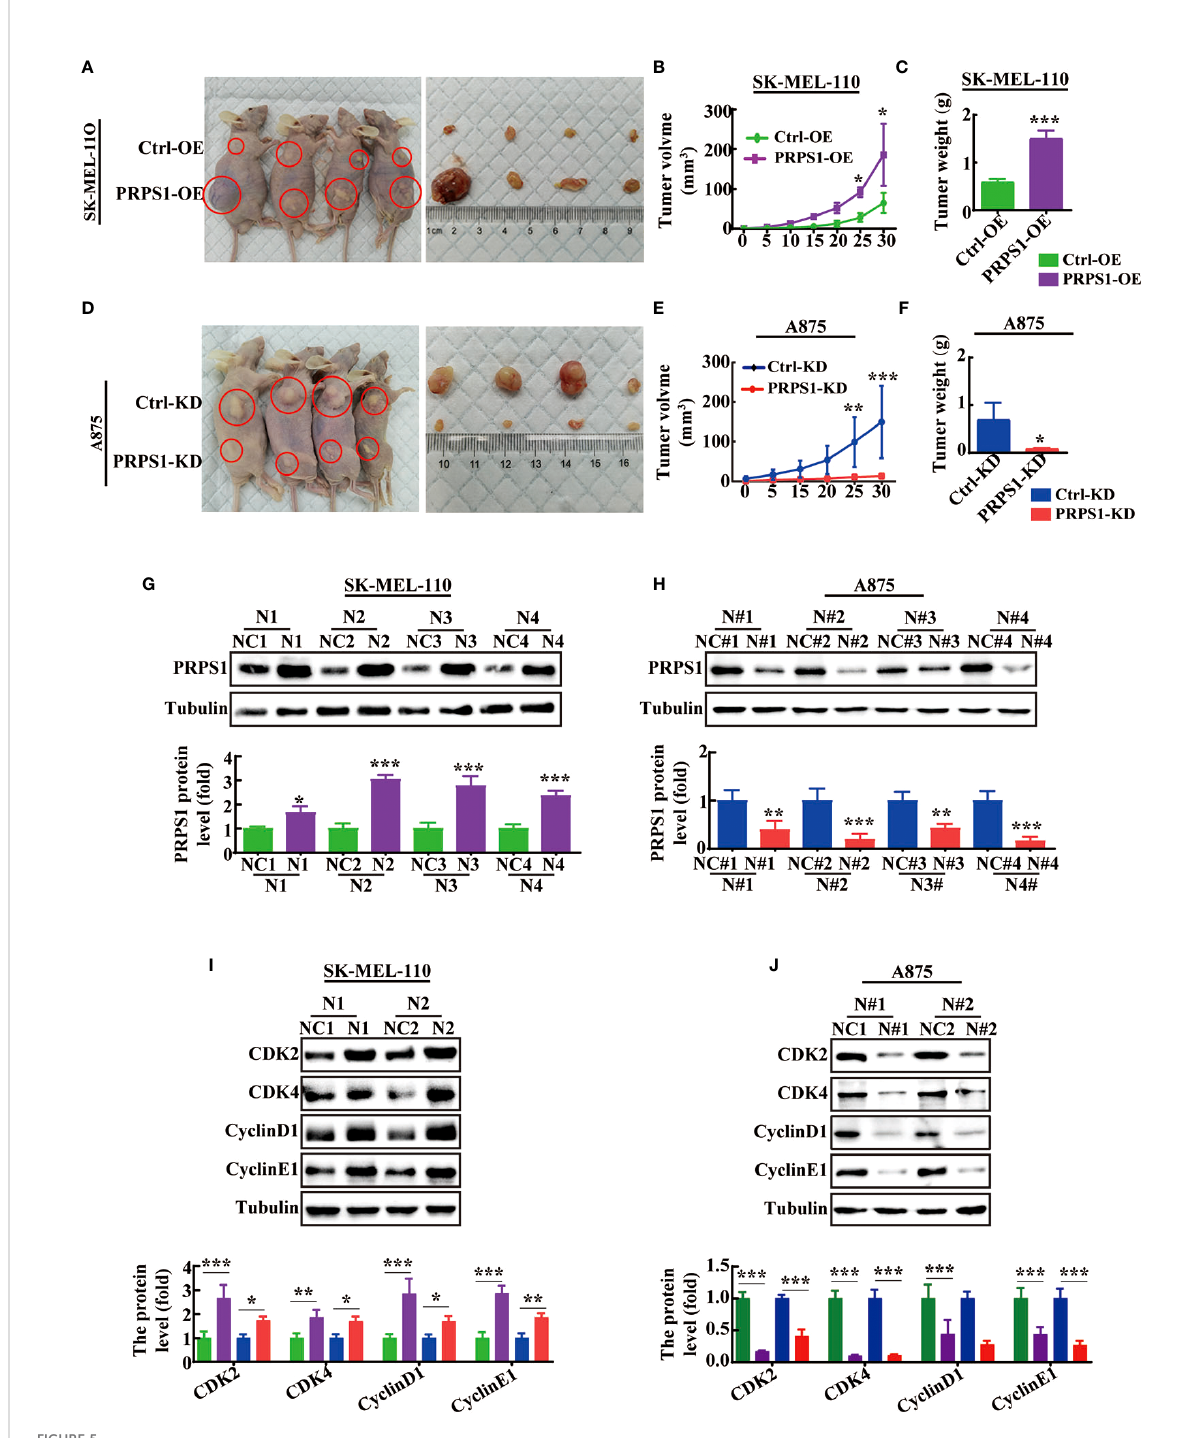
FIGURE 5 PRPS1 promotes melanoma cells proliferation in vivo. (A – C) BALB/c nude mice were injected with SK-MEL-110 cell that were stably transfected with PRPS1 overexpression and the control. Representative images of mice with control (top) and PRPS1-overexpressing (lower) xenograft tumors (A) . The tumor volume (B) and body weight (C) were measured. (n=6/group) (D – F) BALB/c nude mice were injected with A875 cell that were stably transfected with PRPS1 knockdown and the control. Representative photographs of mice with control (top) and PRPS1- knockdown (lower) xenograft tumors (D) . The tumor volume (E) and body weight (F) were measured. (n=6/group) (G – J) The protein level of PRPS1 (G, H) and the cell cycle related protein (I, J) levels of tumors in each xenograft tumors group were measured by western blot analysis. The data represent three independent experiments. The data related to tumor volume were statistically analyzed by two-way ANOVA, and the other data were analyzed by unpaired-sample Student ’ s t test. * P < 0.05, ** P < 0.01, *** P <